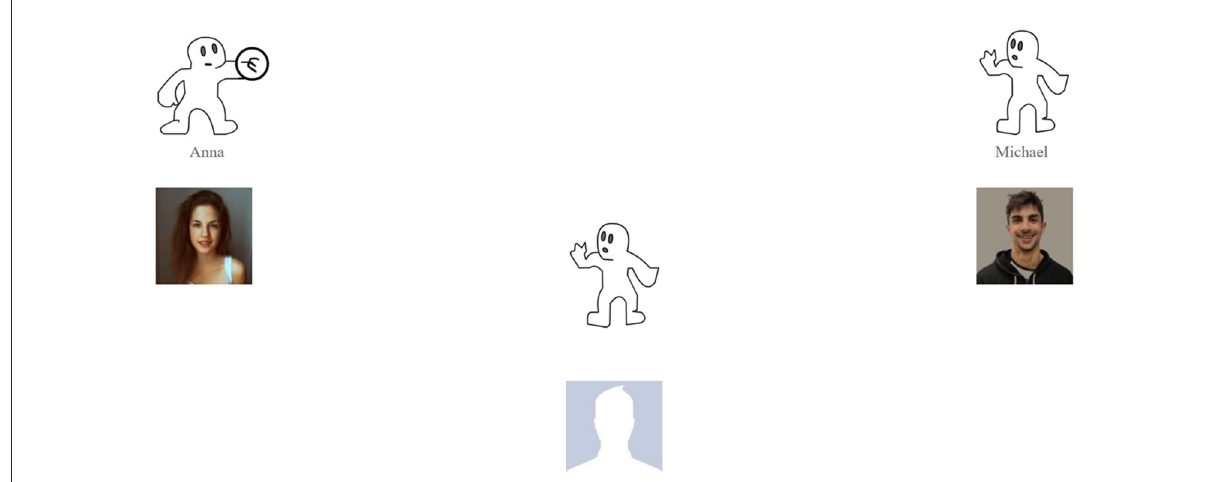
FIGURE2 The Cyberball game from the participant’s point of view. The co-players are on the right and left sides of the screen. The participant is represented by the empty picture at the bottom of the screen. In this scenario, the computer-generated participant Anna is in the possession of the